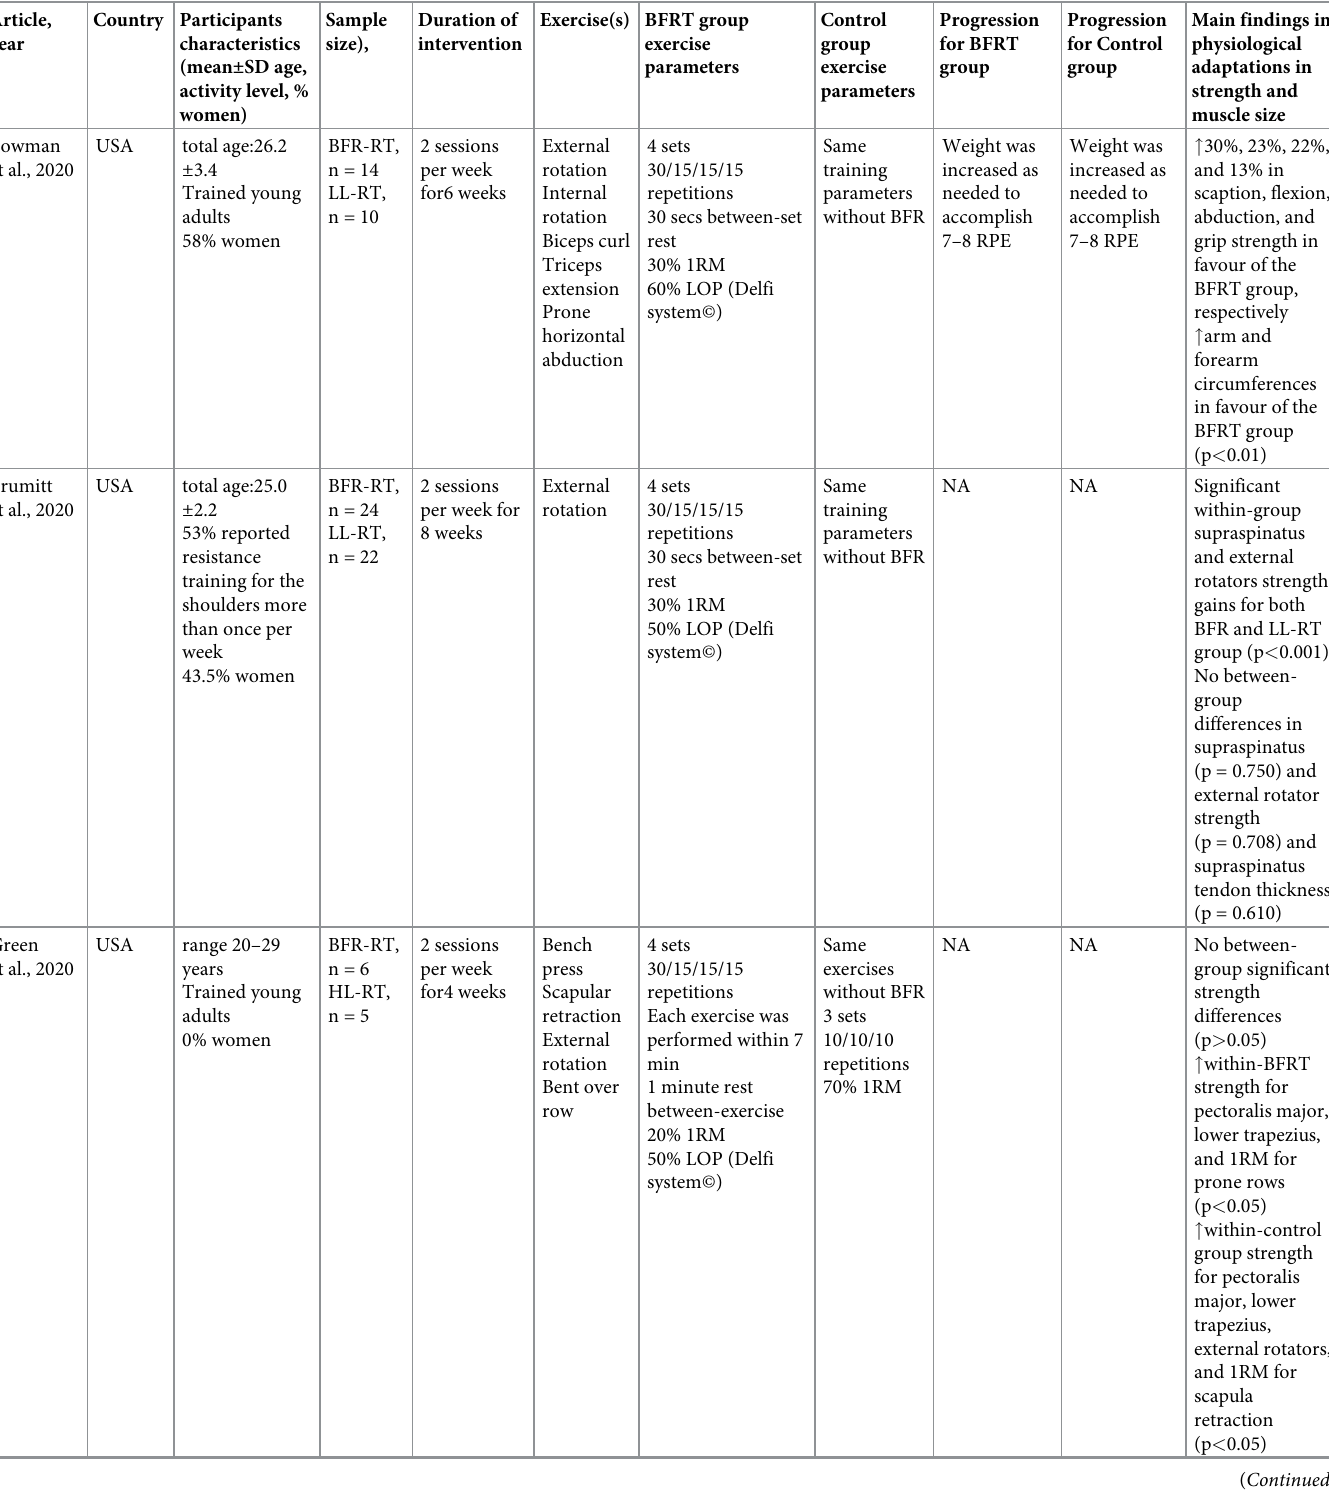
Table 2. Participant and study characteristics, and physiological adaptations and main